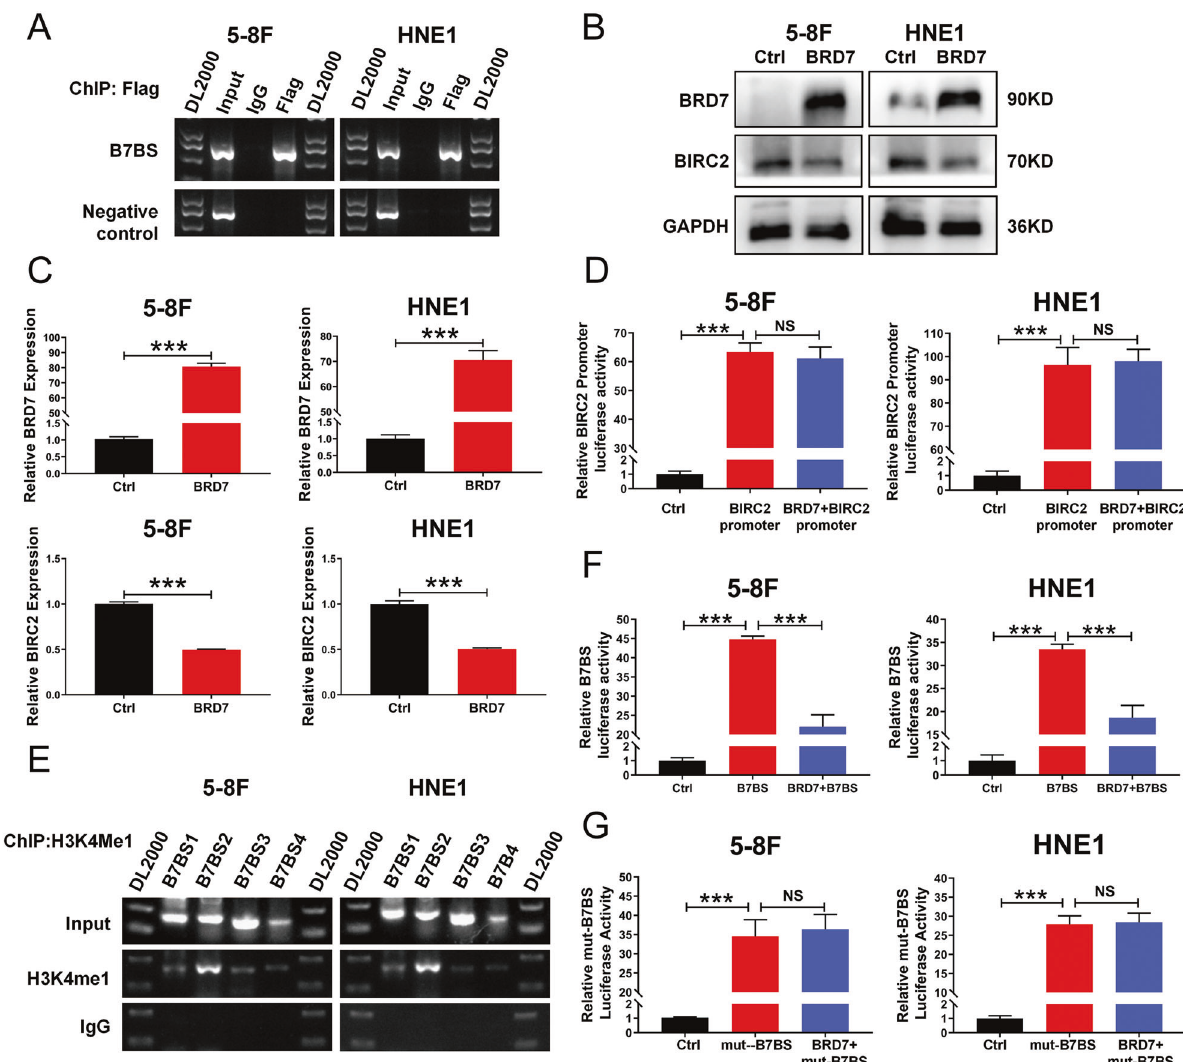
Fig. 1 BRD7 negatively regulates the expression of BIRC2 by inhibiting the activation of the BIRC2 enhancer. A ChIP-PCR assays using antibody speci fi c for Flag was performed to validate the BRD7-binding sites in the 6th intron of BIRC2, while a 400-bp fragment of the BIRC2 potential promoter region without BRD7 binding site was used as a negative control. B Western blotting using antibodies against BRD7 and BIRC2 was performed to con fi rm BRD7 and BIRC2 protein levels. GAPDH served as an internal control. C qRT-PCR assays were used to con fi rm BRD7 and BIRC2 mRNA levels. GAPDH served as an internal control. D The dual-luciferase reporter assays was performed to determine the effect of BRD7 on the promoter activity of BIRC2. E ChIP-PCR assay using antibodies speci fi c for H3K4me1 was used to validate the H3K4me1 enrichment at the B7BS, and B7BS was divided into four PCR fragments of about 200 bp, each fragments was ampli fi ed with each pair of primers. ( F ) and ( G ) The dual-luciferase reporter assays were used to determine the enhancer activities of B7BS and mut-B7BS and the effect of BRD7 on their activities. The error bars are presented as the mean ± SD. ***P < 0.001; NS, no signi fi cance. All experiments were performed in